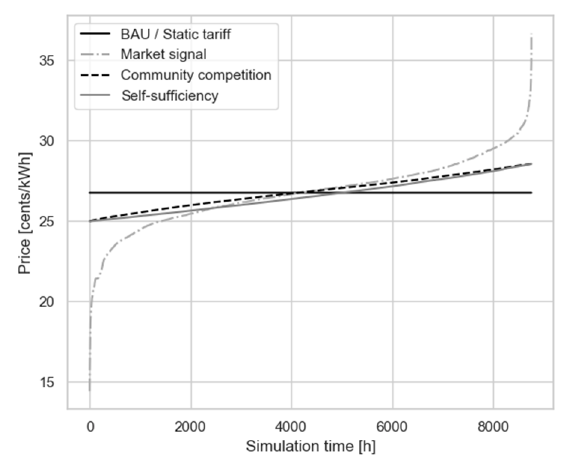
Figure 7. The duration curve of electricity tariffs in different scenarios.